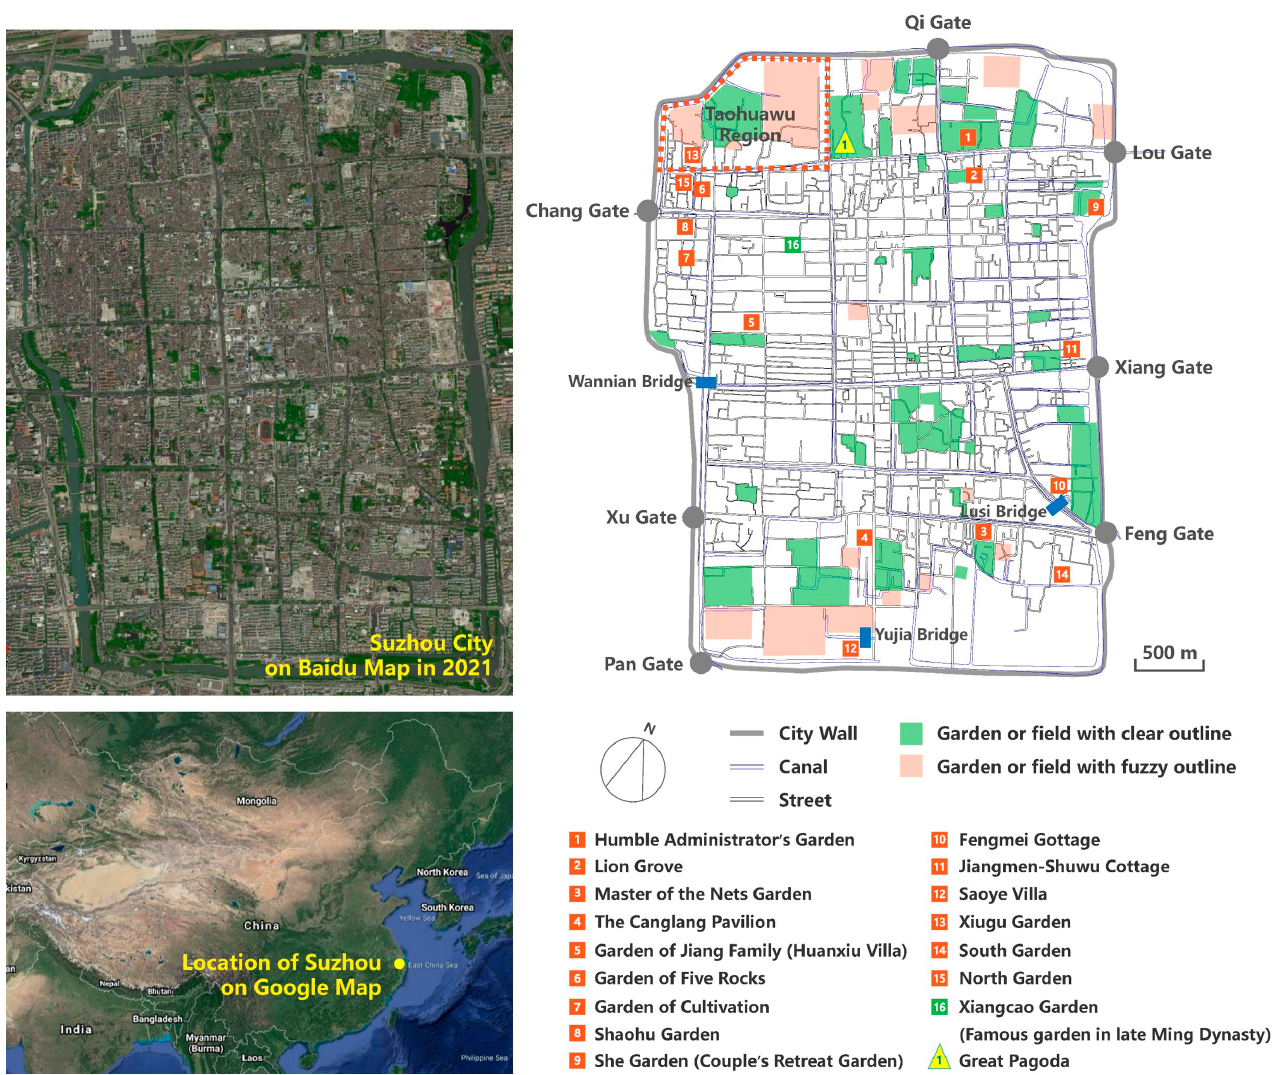
Figure 2. Translation of the Map of Suzhou City by scientific